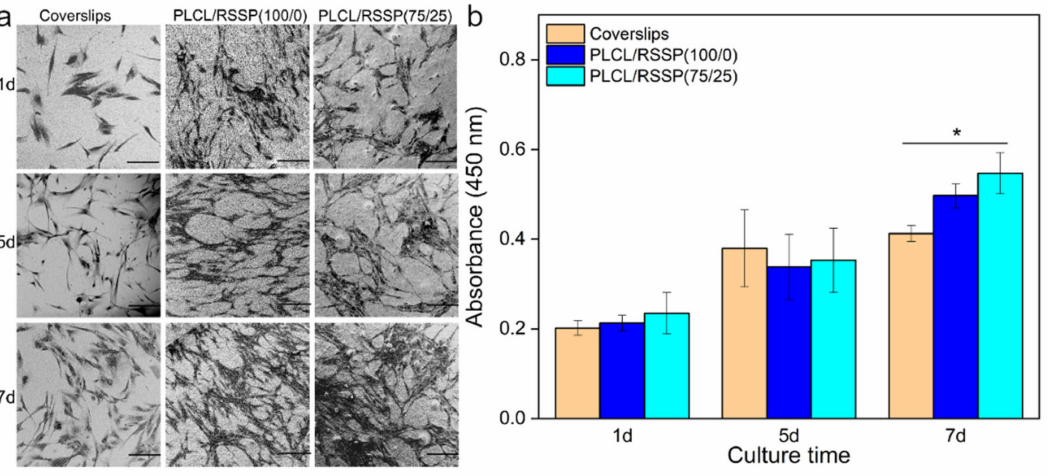
Figure 6. SEM images ( a ) and quantitative analysis ( b ) of the proliferation of hFFCs on the cover slips of PLCL/RSSP (100/0) and PLCL/RSSP (75/25) membranes. (Scale bar: 200 µ m. * p <